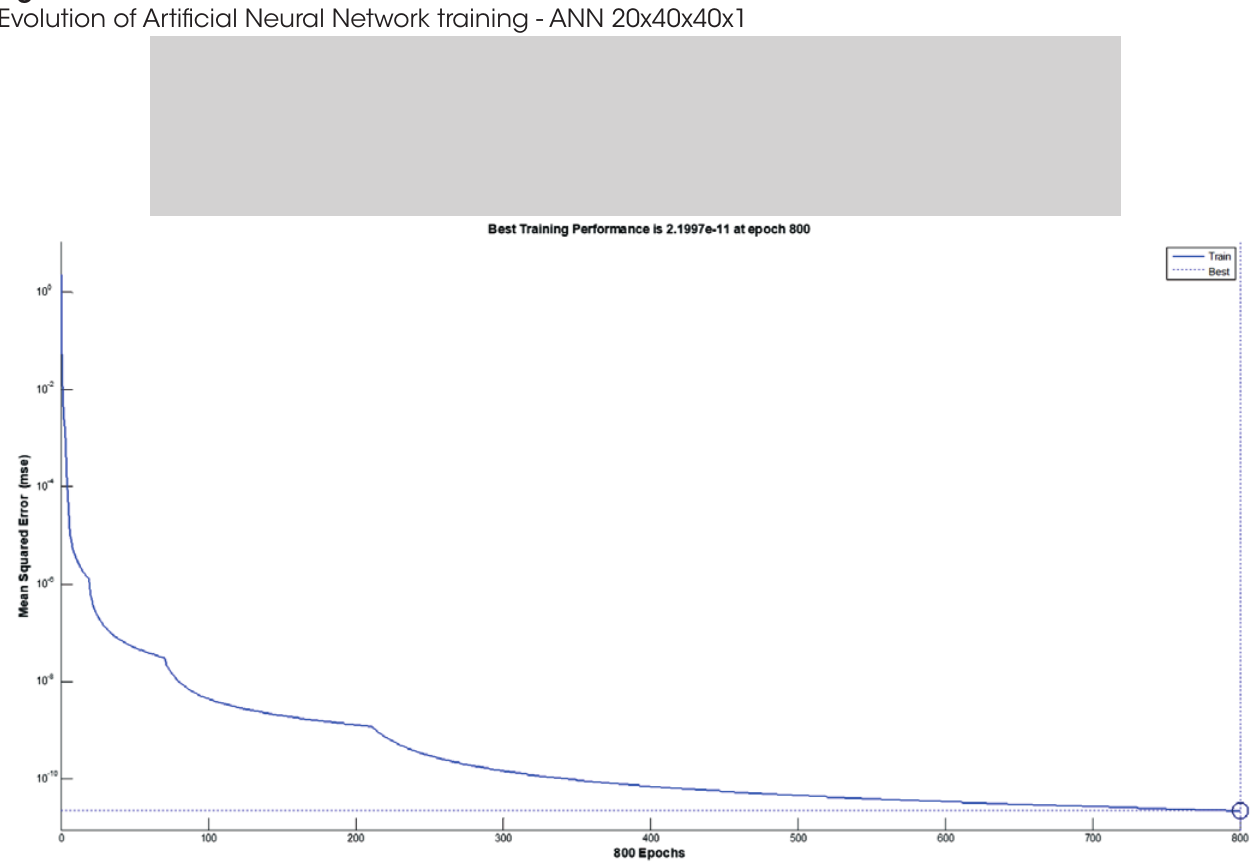
Evolution of Artificial Neural Network training - ANN